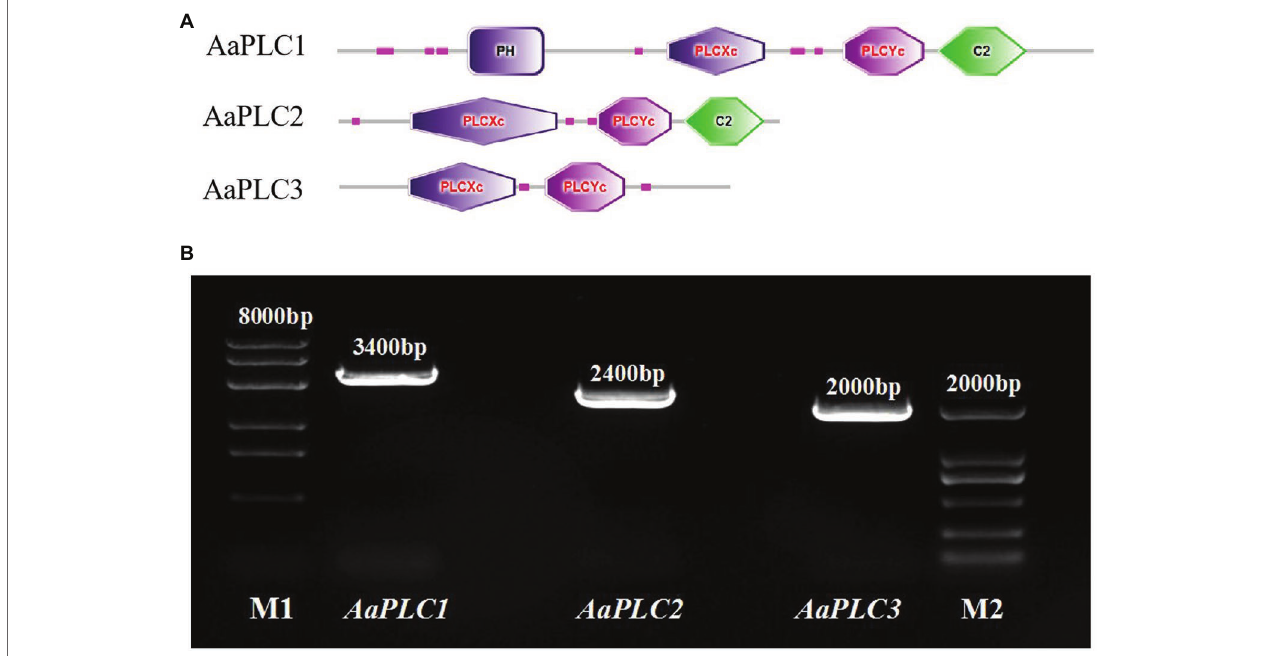
FIGURE 1 | Characteristics of the Alternaria alternata phospholipase C ( PLC ) gene. Schematic of conserved domain predictions of the AaPLC gene products (A) . PCR amplification of PLC encoding genes in A. alternata (primers are shown in Table 2 ), M1, DL8000 DNA marker; M2, DL2000 DNA marker (B)